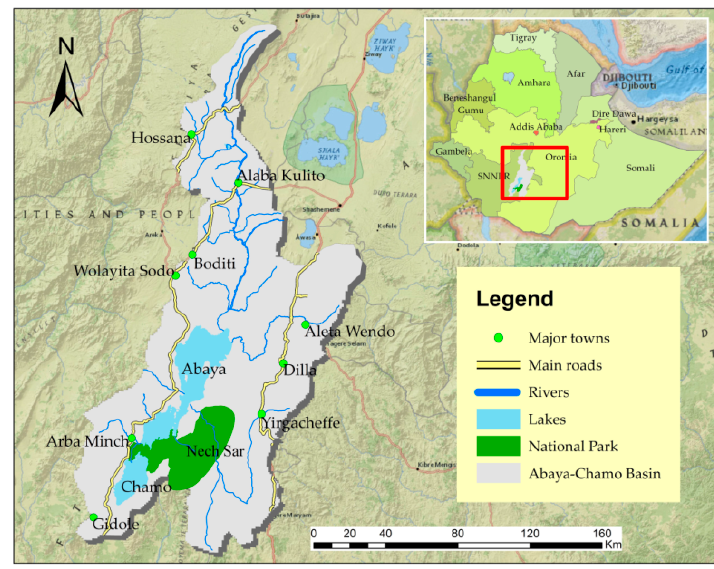
Figure 1. Map of the study area.